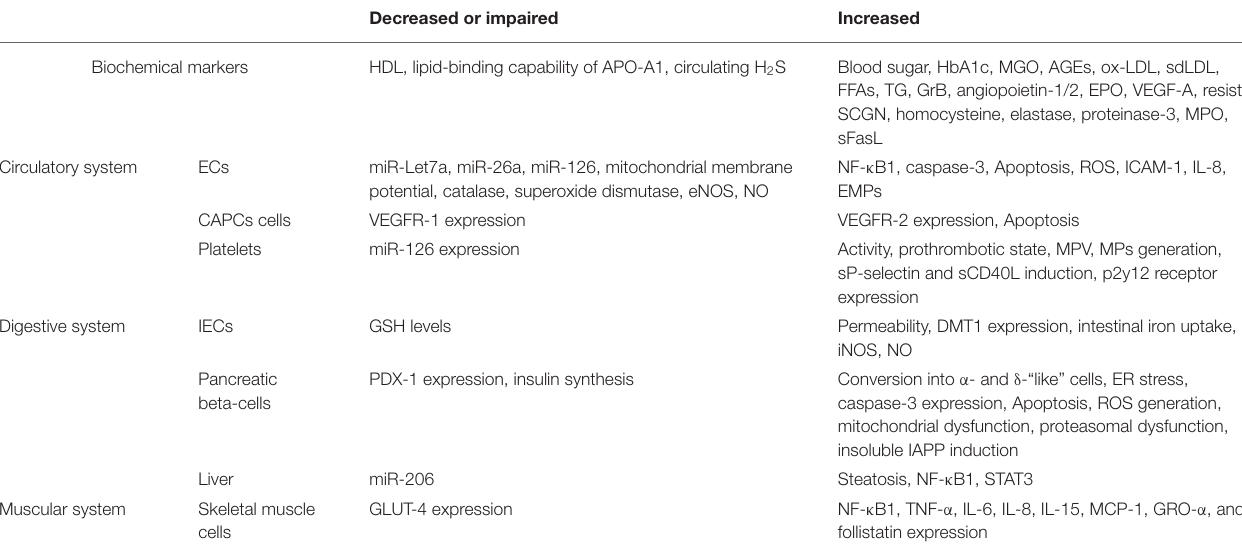
TABLE 1 | Effects of type 2 diabetes mellitus on biochemical markers, as well as circulatory, digestive, and muscular